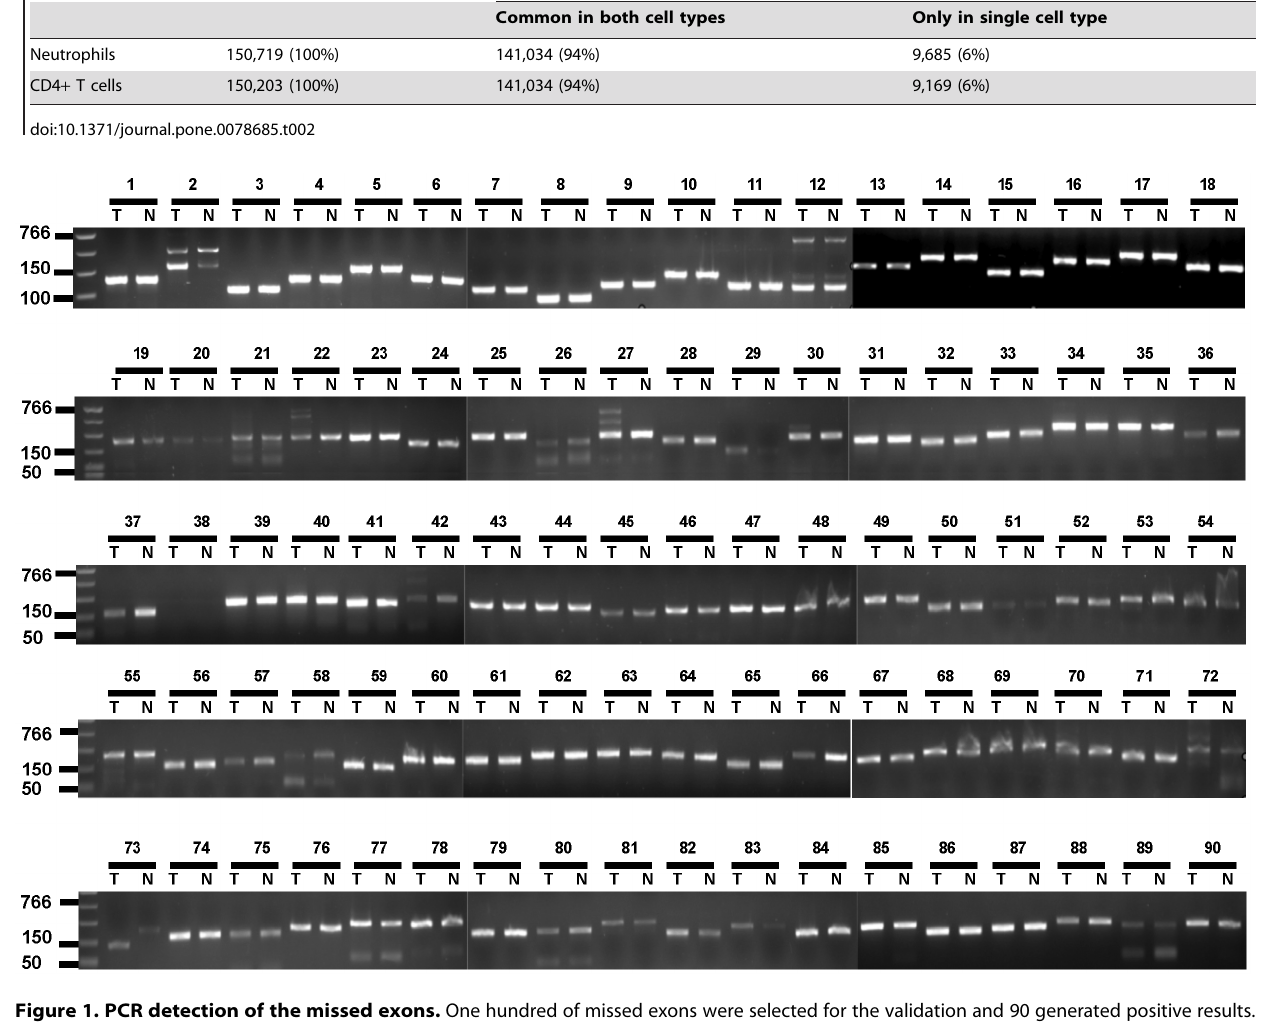
Figure 1. PCR detection of the missed exons. One hundred of missed exons were selected for the validation and 90 generated positive results. Except # 73, all 89 reactions detected the missed exons with the same sizes between T cells and neutrophils. T: CD4 + T cells; N: neutrophils.